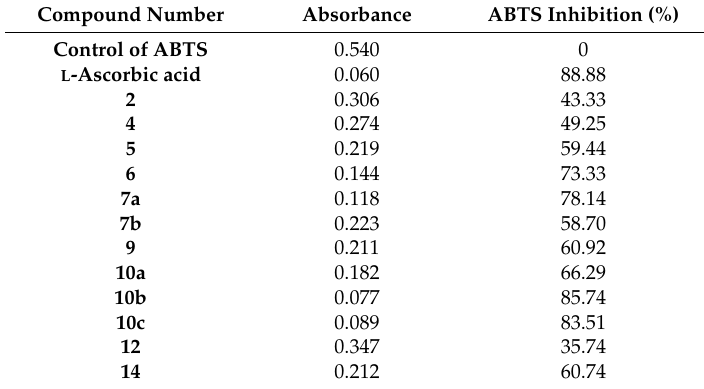
Table 2. ABTS scavenging activity of the synthesized 4-antipyrinylthiazole